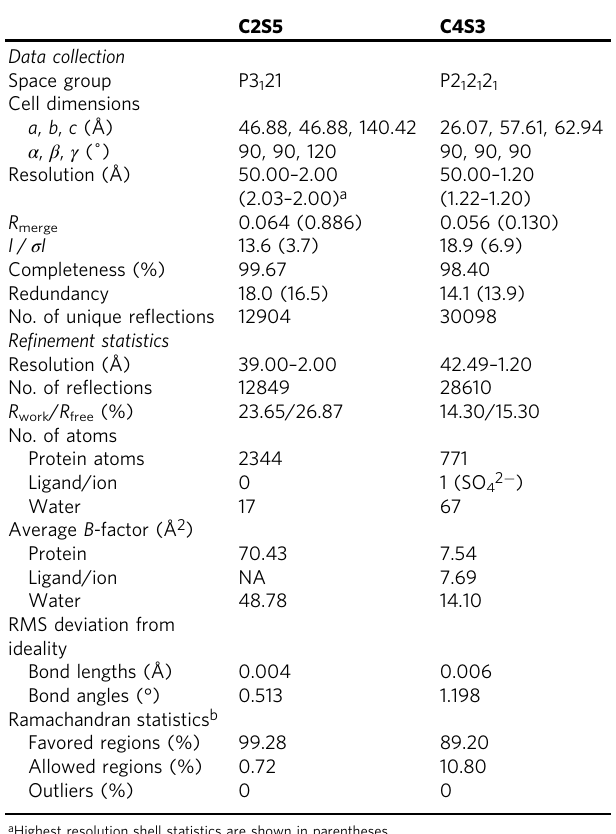
Table 1 Crystallographic data collection and re fi